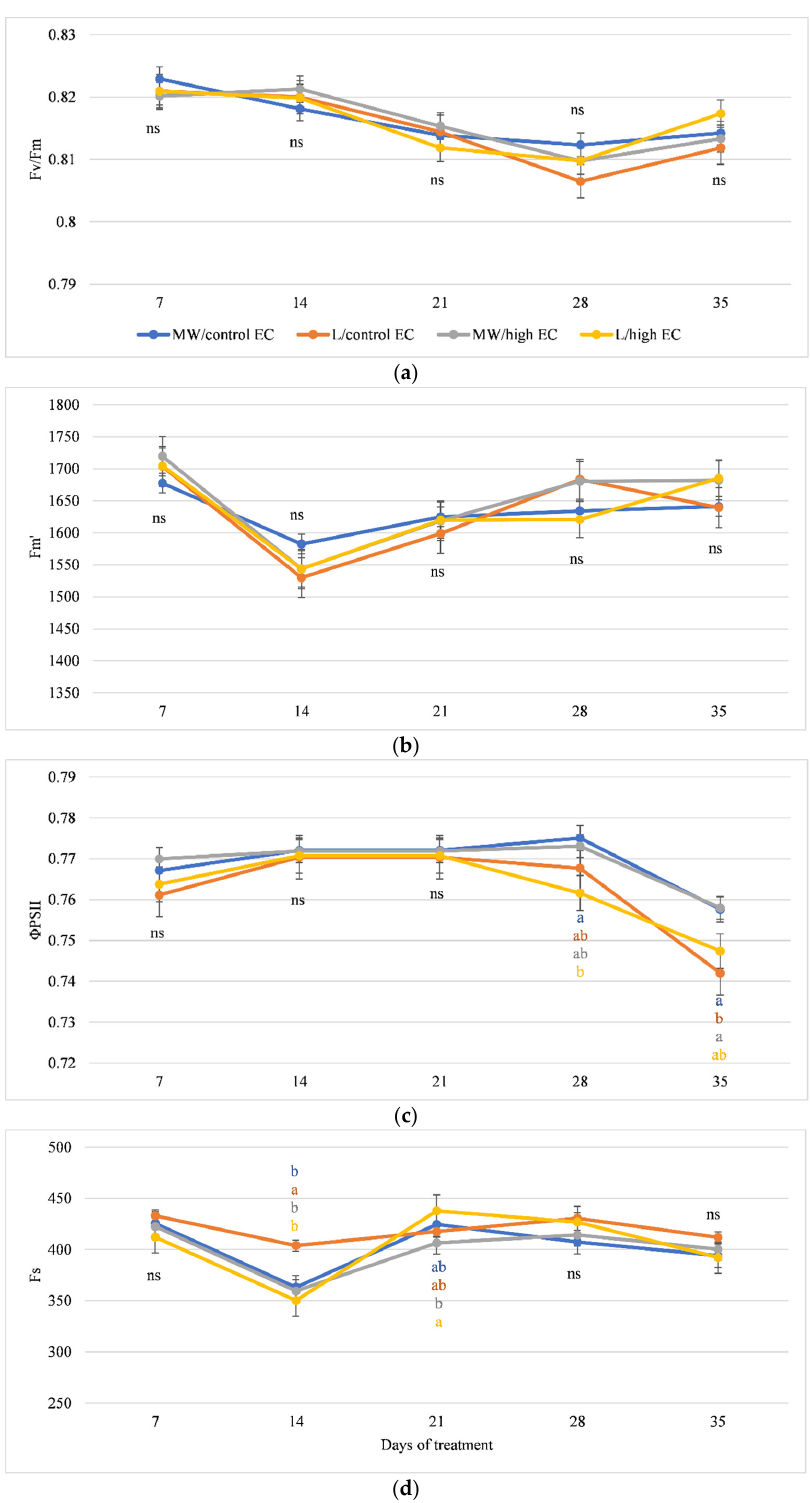
Figure 4. Effect of high nutrient solution EC on maximum photochemical yield of PSII (Fv/Fm) ( a ), maximum chlorophyll a fluorescence in dark-adapted leaves (Fm’) ( b ), the maximum quantum yield of PS II ( Φ PSII) ( c ), and stationary fluorescence (Fs) ( d ) of cucumber plants depending on the medium used on 7, 14, 21, 28, and 35 DAEC (average from two years). Vertical bars indicate ± standard deviation. Abbreviations: ns, not significant. Average values marked with the same letters are not significantly different within the analyzed parameter at p <